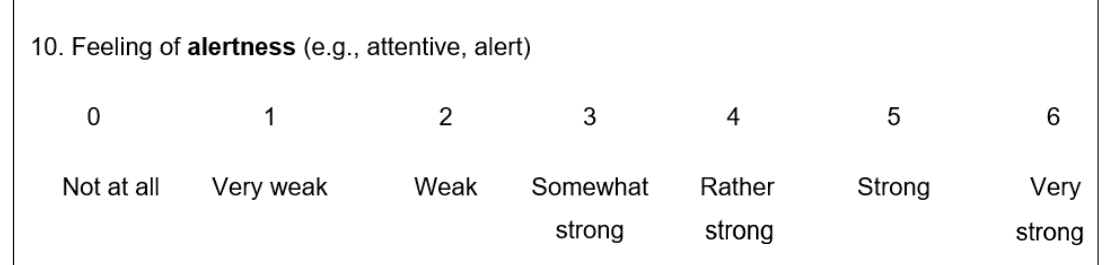
Figure 1. Example of an item from the BSKE-EA 17 scale with gradation and coding.